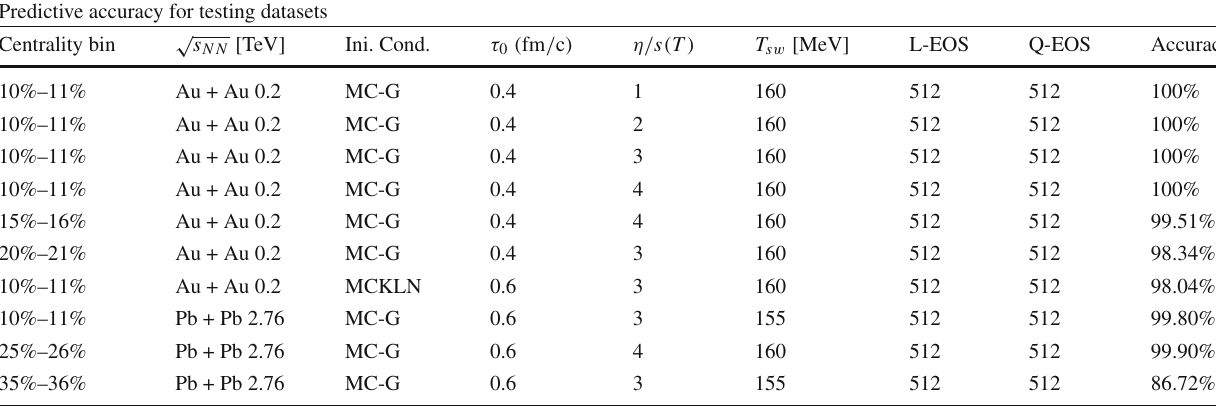
Table11 Predictiveaccuracyontestingdatasets5:30-events-fine-averagedspectra ρ a ( p T ,(cid:6)) generatedwiththedifferent temperature-dependent η/ s ( T ) , τ 0 , and T s w in the centrality range 0–30% Predictive accuracy for testing